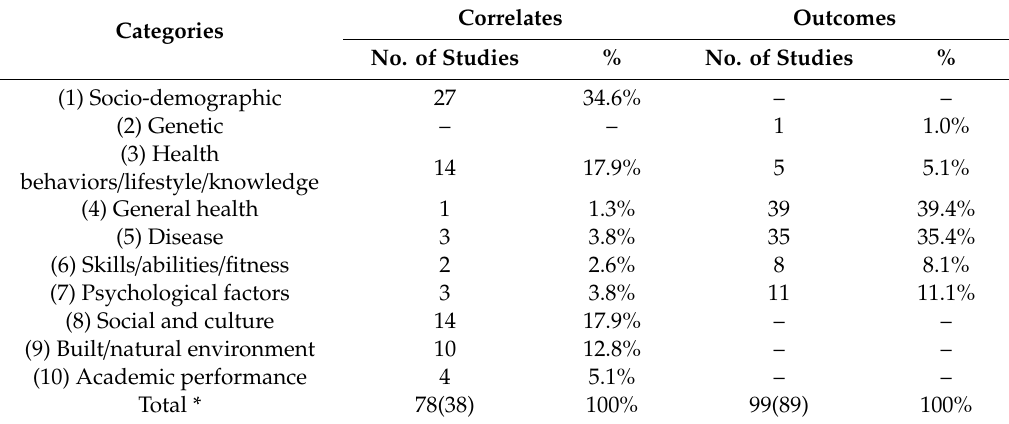
Table 3. Number of studies investigating the correlates and outcomes of